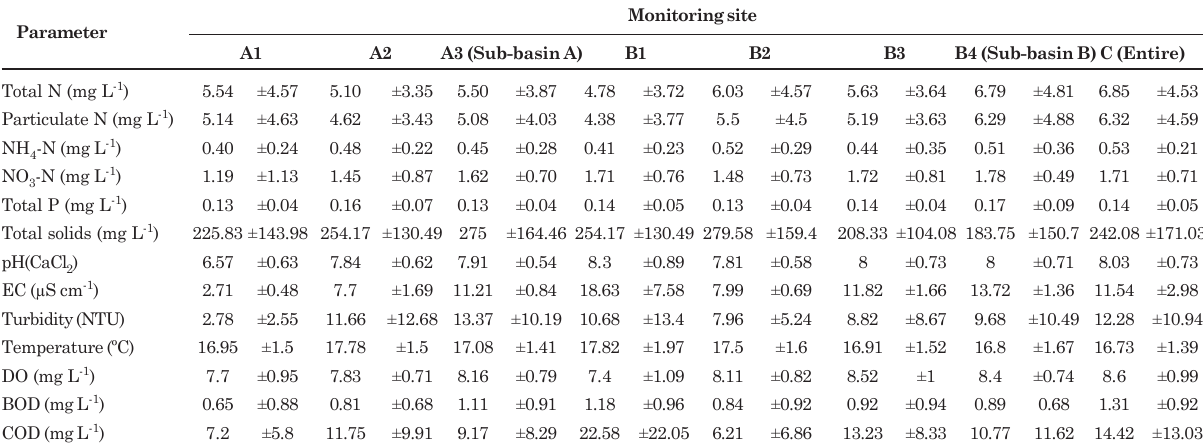
Table 8. Annual average concentrations (± standard deviation) of water quality parameters in the Campestre